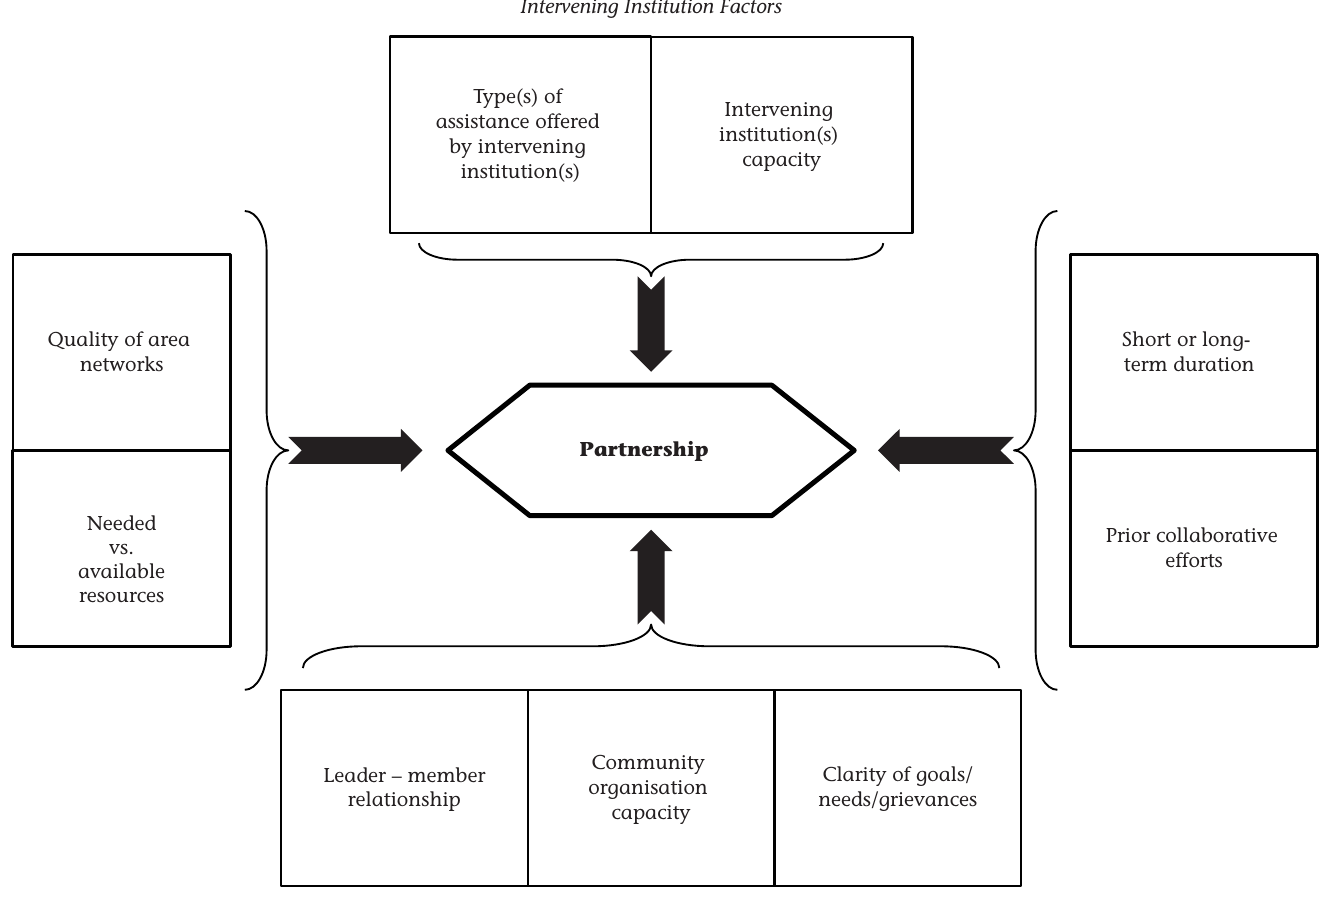
Figure 1: Factors